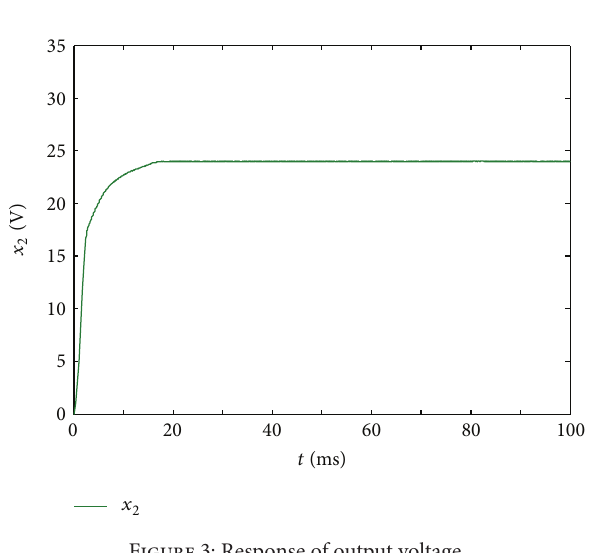
Figure 3: Response of output voltage.